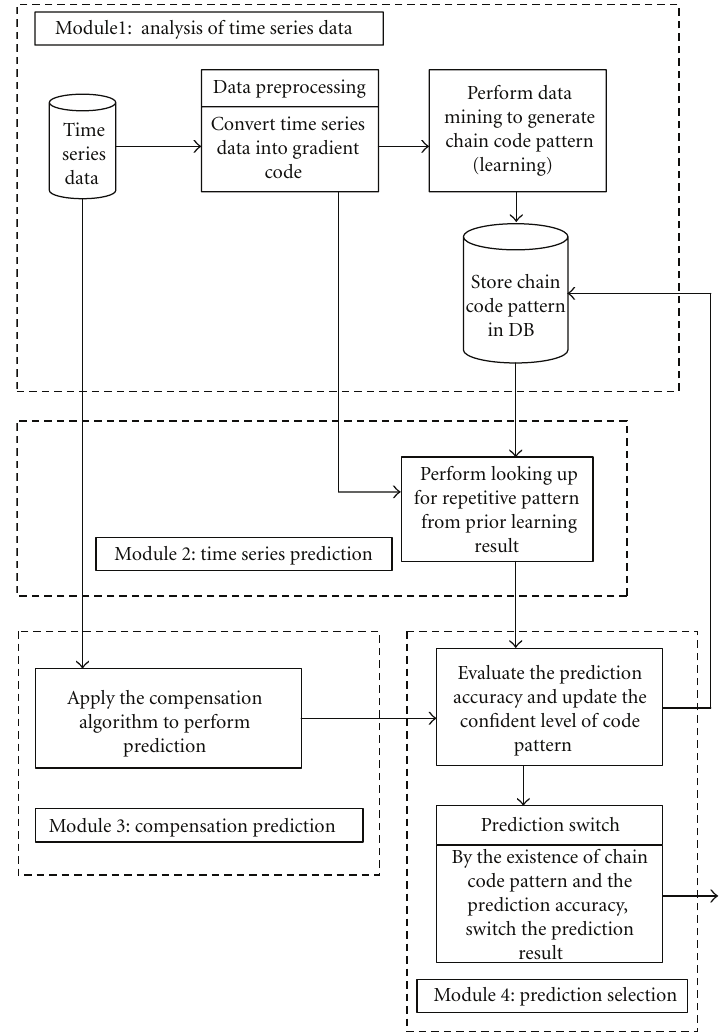
Figure 1: The process flow diagram of the proposed prediction method.